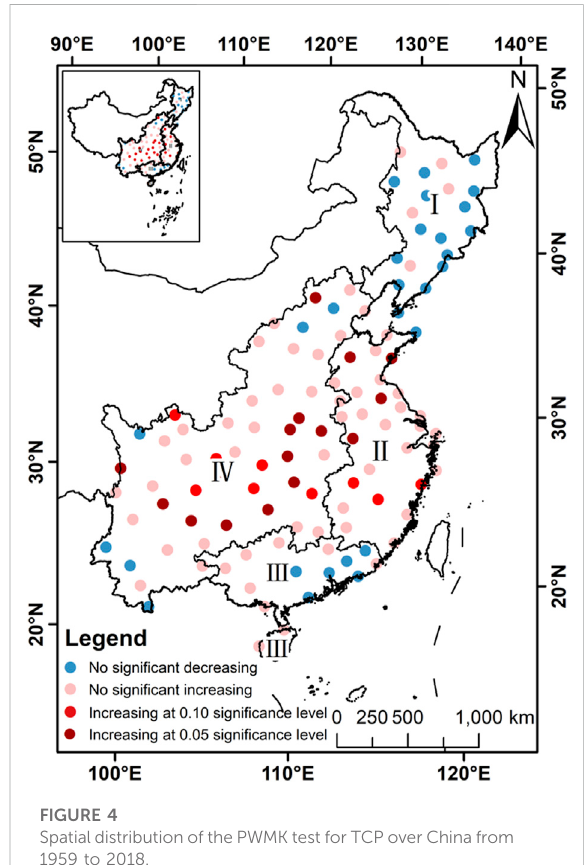
FIGURE 4 Spatial distributionof thePWMK testfor TCP over Chinafrom 1959 to 2018.